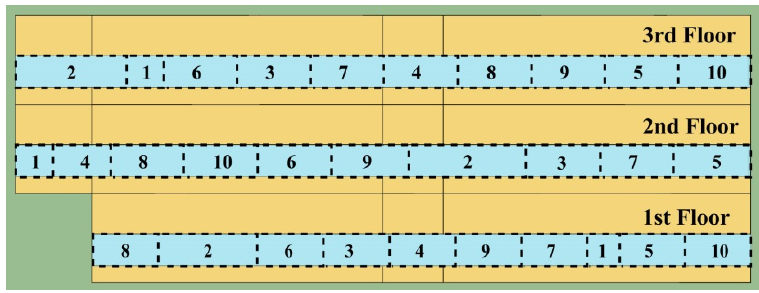
Figure 4. Window randomization of West